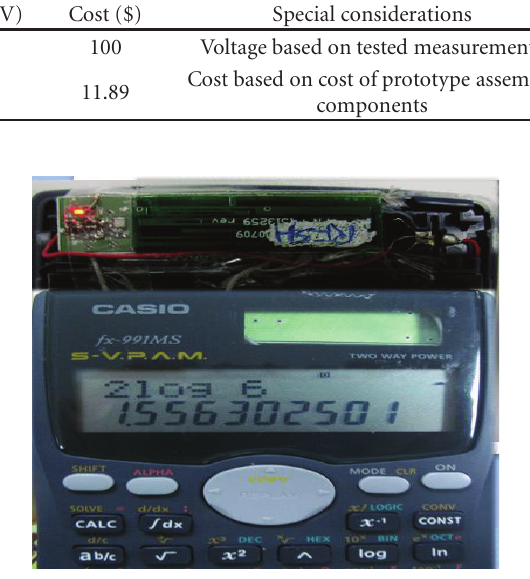
Figure 16: Back and front sides of the calculator running with the proposed RF signal